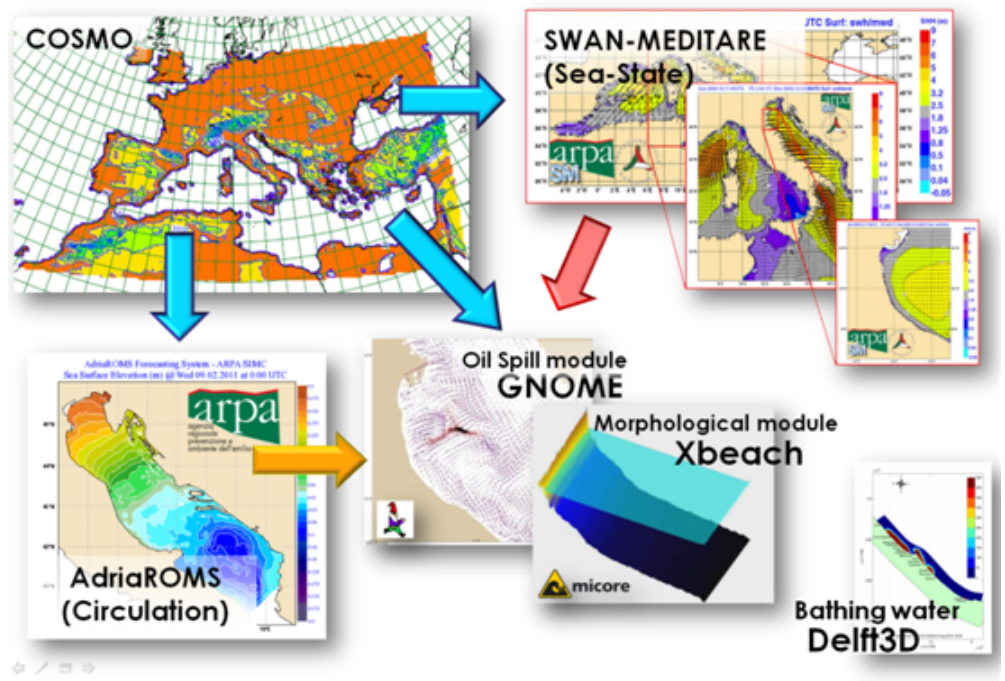
Figure 6. The operational modeling system and the meteo-marine products provided by